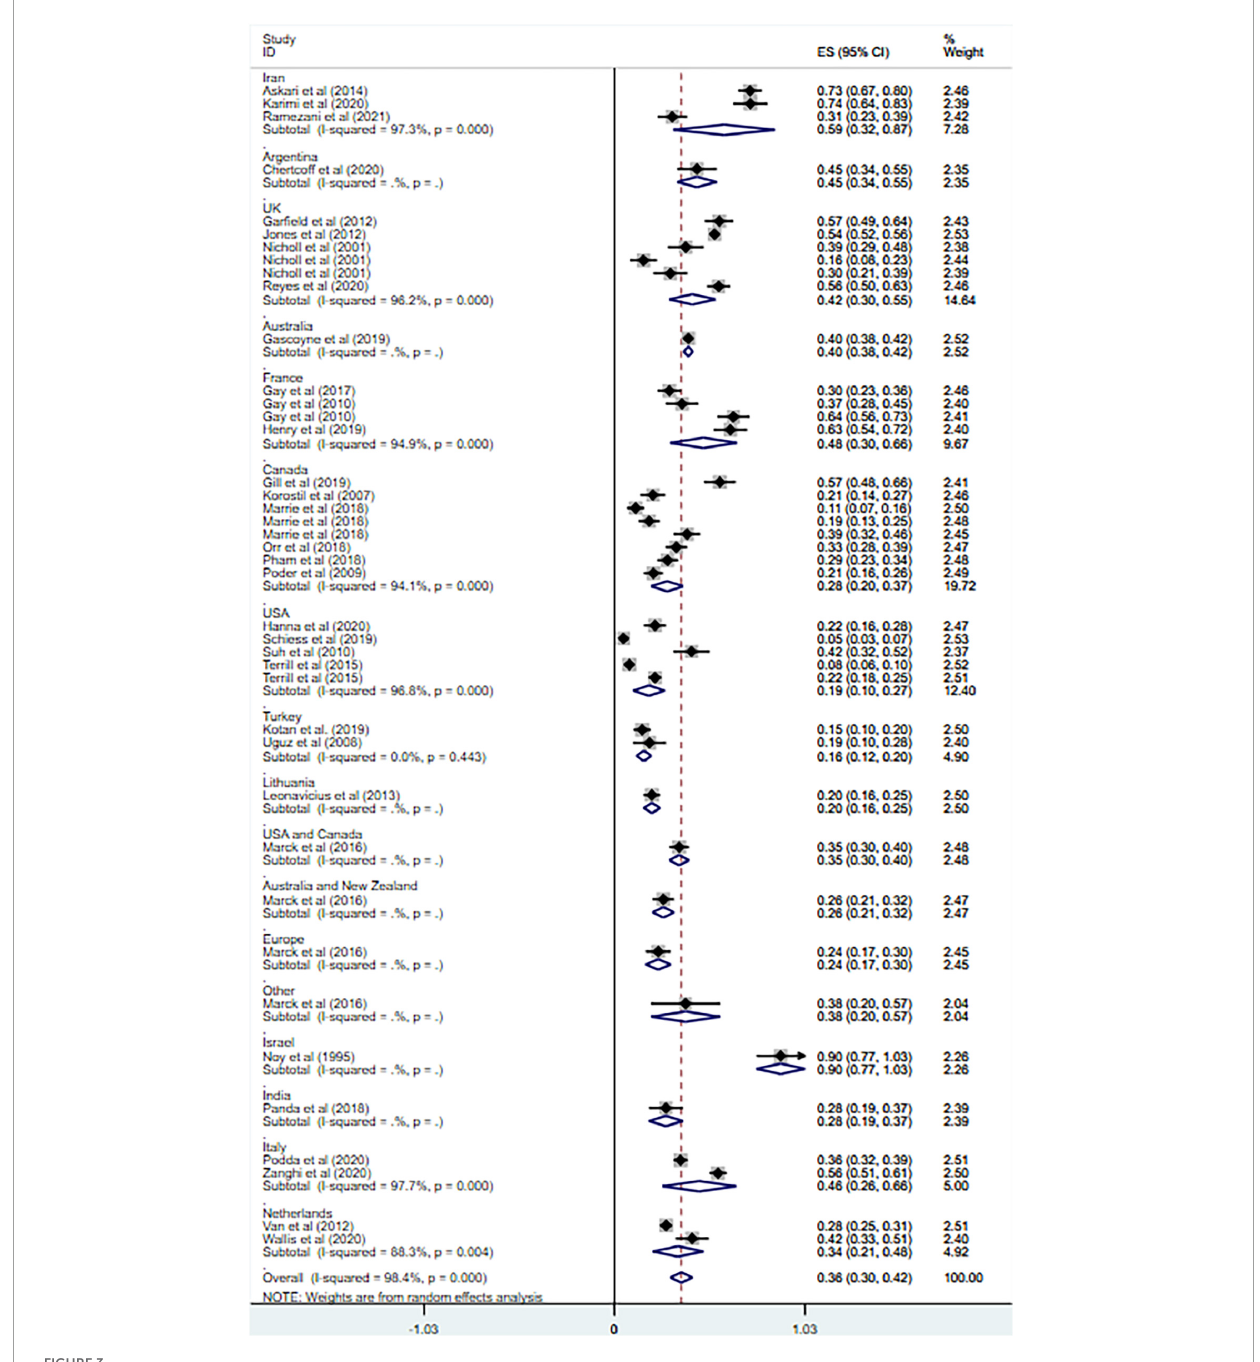
likely to have anxiety (OR 2.83, 95% CI = [1.74–4.59], p < 0.001) (see Supplementary Figure 10 ). And those living with other family members were more anxious than those living alone (OR 2.83, 95% CI = [1.74–4.59], p < 0.001) (see Supplementary Figure 11 ). But no significant effect of family history of psychiatric disorders on anxiety was found (OR 2.42, 95% CI = [1.56–3.75], p = 0.158) (see Supplementary Figure 12 ). No significant heterogeneity was perceived for the above three risk factors ( I 2 = 0). For EDSS scores at baseline, those with higher scores were probably less likely to